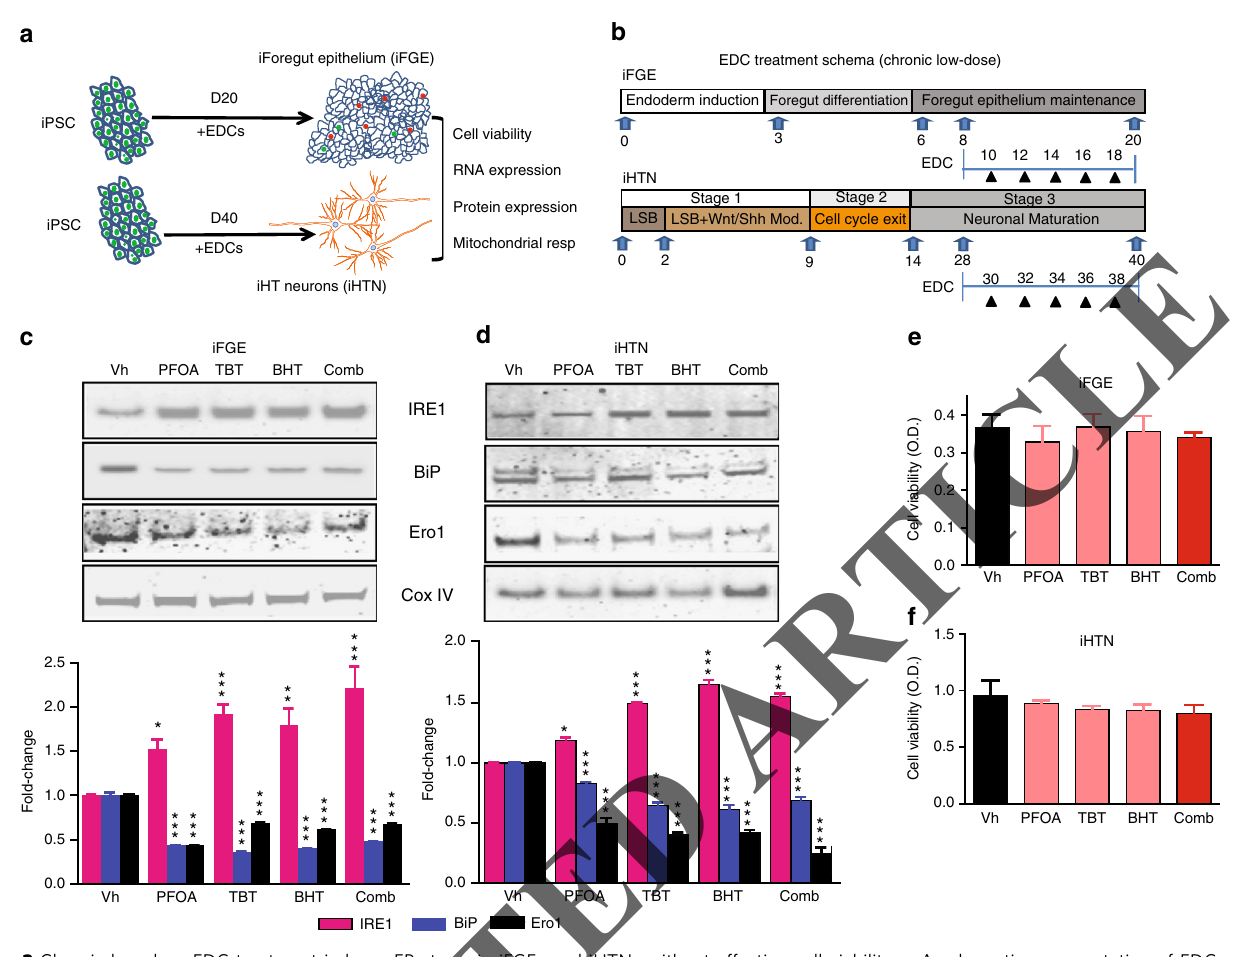
Fig. 3 Chronic low-dose EDC treatment induces ER stress in iFGEs and iHTNs without affecting cell viability. a A schematic representation of EDC treatments and analysis performed on iFGEs and iHTNs. b A schematic showing the kinetics of EDC treatments performed on iFGEs and iHTNs. c , d Representative immunoblots showing levels of bona fi de ER-stress pathway proteins, IRE1, BiP, and Ero1, in c iFGE and d iHTNs. Quanti fi ed histograms using ImageJ-based densitometry of bands for each of the respective protein immunoblots normalized to Cox IV as loading control are shown below and represented as fold-change compared with vehicle-treated control. IRE1 protein increases, whereas BiP and Ero1 levels decrease in response to EDC exposure, * p < 0.05, ** p < 0.01, *** p < 0.001. e , f MTT assay shows no signi fi cant differences in cell viability upon EDC exposure in both e iFGEs and f iHTNs. All statistical analyses were performed using one-way ANOVA. Data shown are representative of average results from the two iPSC lines differentiated n = 3 times in independent experiments. Error bars denote